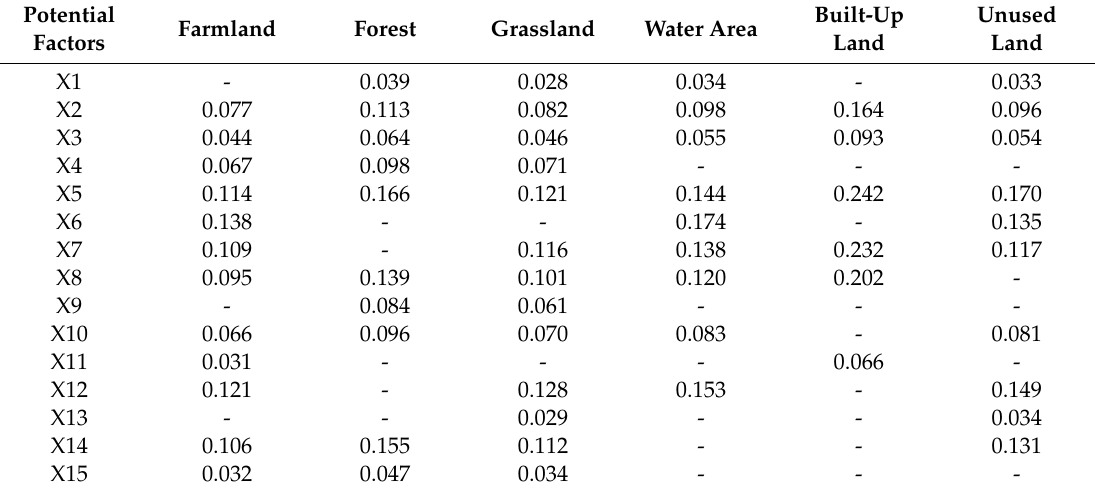
Table 2. Weights of selected driving